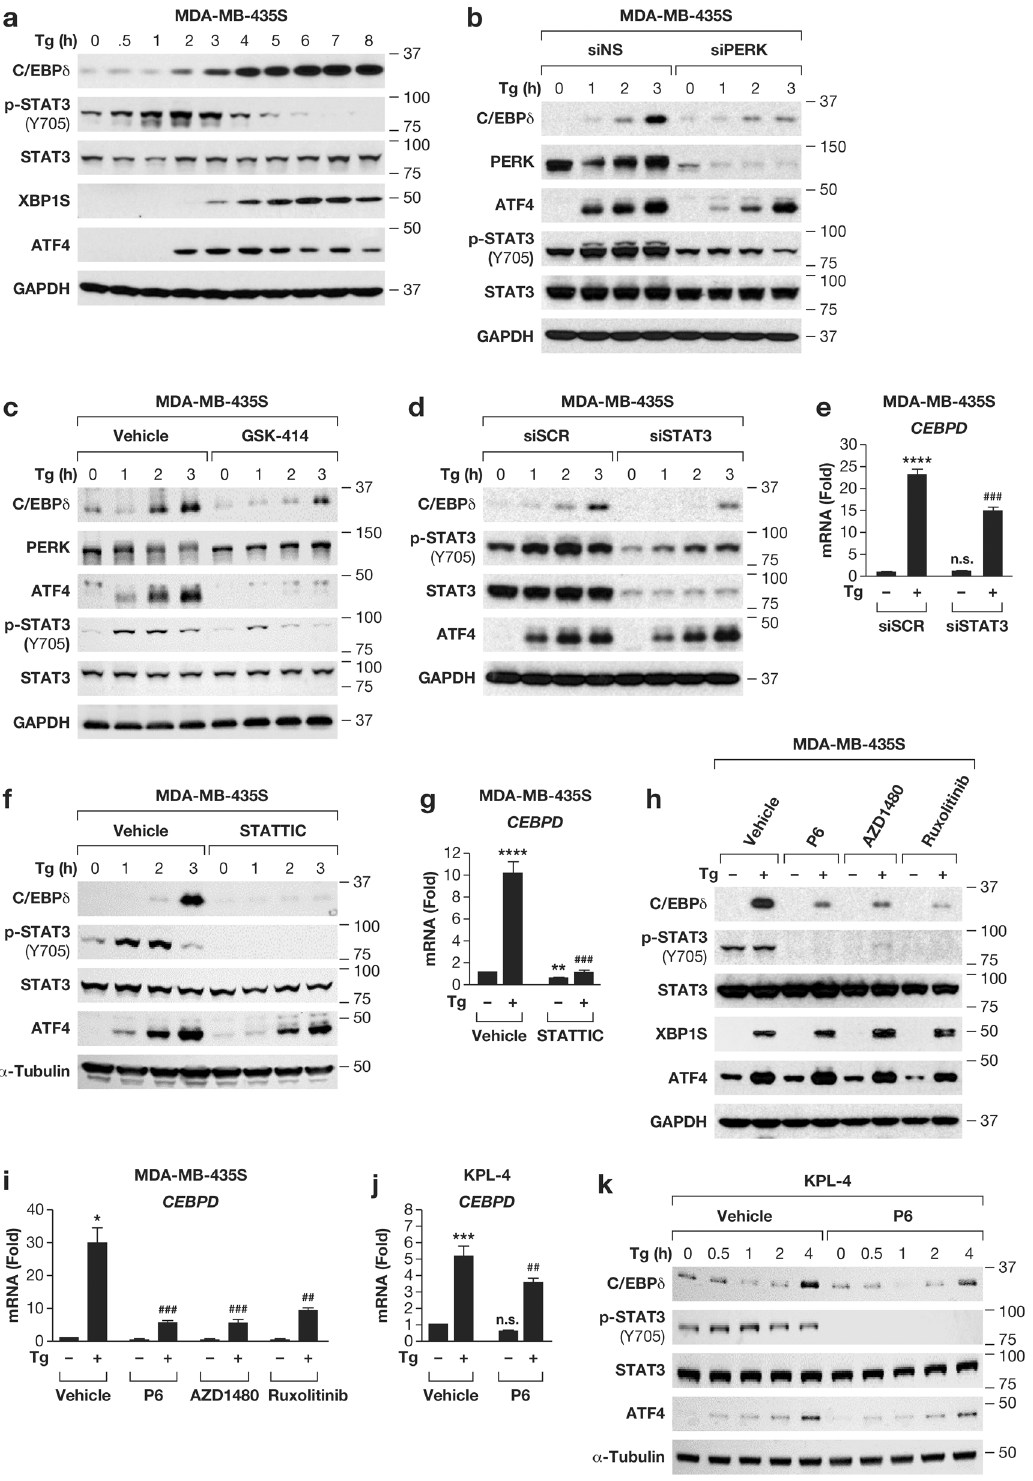
with different kinetics (Fig. 6c, d). CXCL8 protein accumulated steadily in media from pulse-treated MDA-MB-435S cells, while CCL20 protein was only detectable after 24 h at low concentration (Fig. 6e, f). Prolonged activation of the UPR by short-term treatment is likely due to thapsigargin ’ s mechanism of irreversible inhibition of the SERCA protein